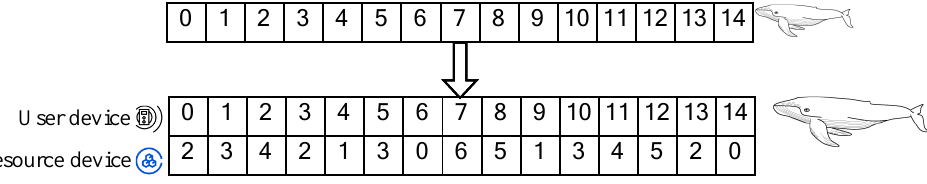
Figure 2. Resource equipment and user task encoding